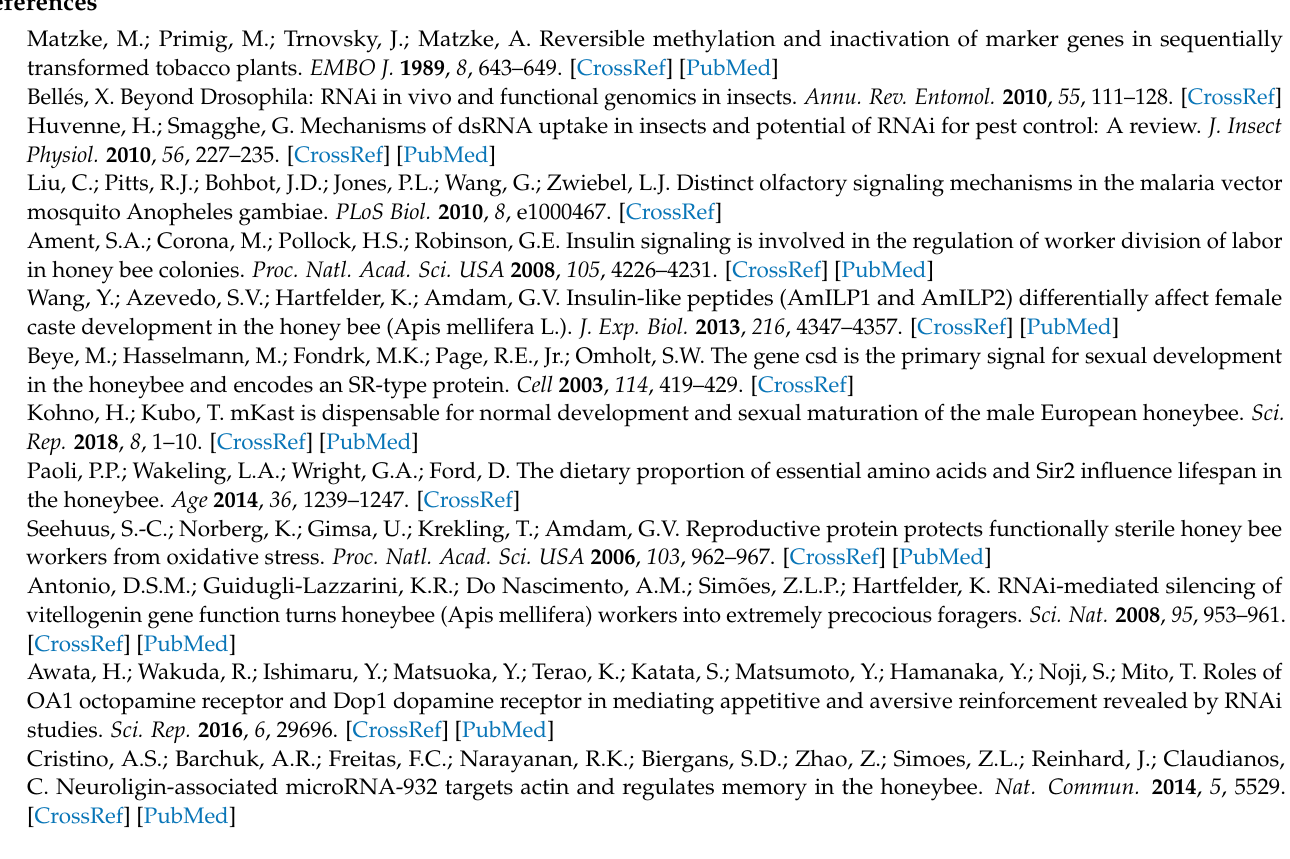
siRNA. Table S1: Pairwise comparison of the effects of different delivery methods and different modified siRNA methods on honey bee mortality. Table S2: Effects of different delivery methods and different modified siRNA methods on the expression of ALDH7A1 in honey bees. Table S3: Effects of different delivery methods and different modified siRNA methods on the expression of 4CL in honey bees. Table S4: Effects of different delivery methods and different modified siRNA methods on the expression of HSP70 in honey